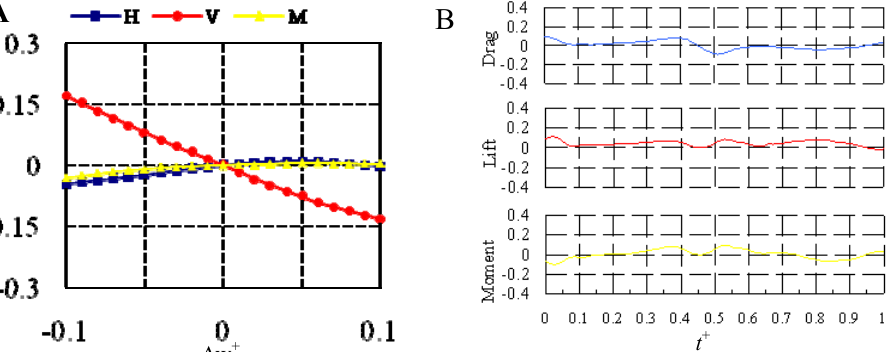
Fig. 6 (A) x -component and z -component of forces and pitching moment when the z -component velocity w varies in a range of -0.1~0.1. (B) Time course of the differences in lift, drag and pitching moment with respect to the reference flight condition at Δ w + =0.06 . t + is a